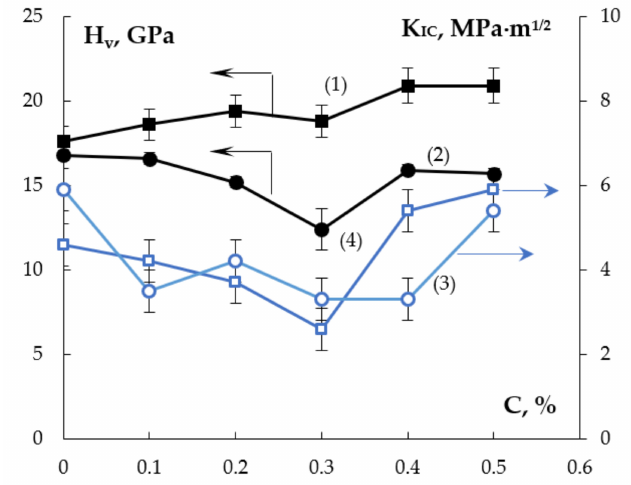
Figure 9. Dependence of microhardness (1, 2) and fracture toughness (3, 4) of fine-grained hard alloy WC-10Co on the graphite content. (1, 3)—specimens obtained by solid-phase sintering at 1100 ◦ C, (2, 4)—specimens obtained by liquid-phase sintering at 1400 ◦